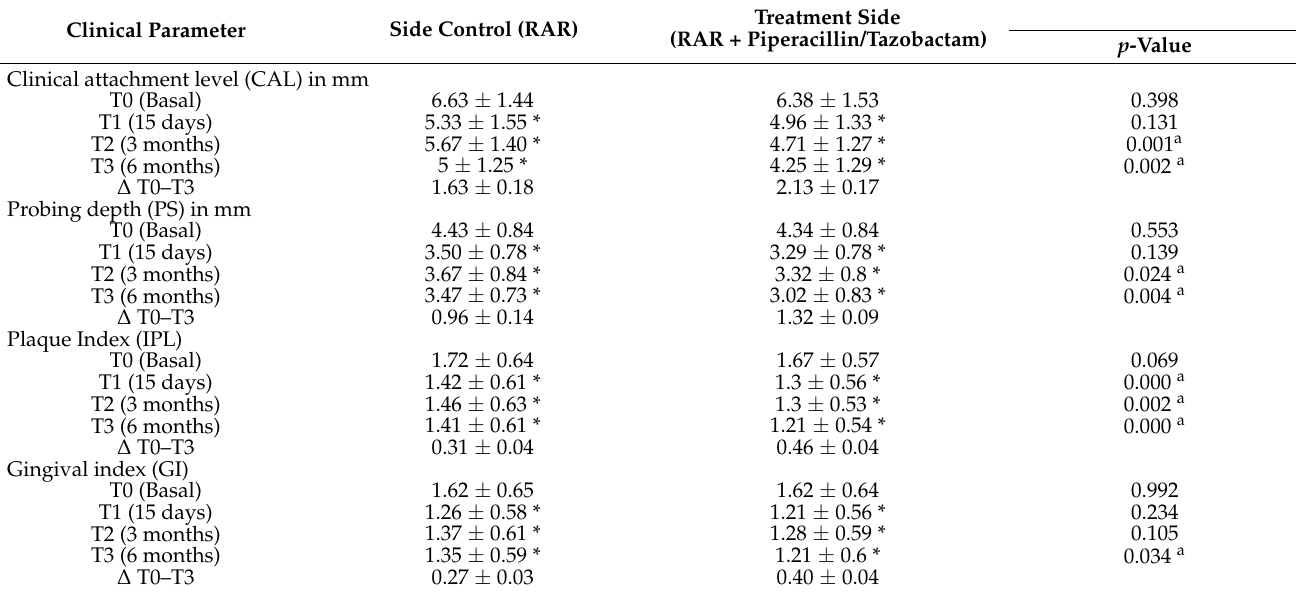
Table 2. Comparison of CAL, PS, IPL, and IG intergroup and intragroup in the different